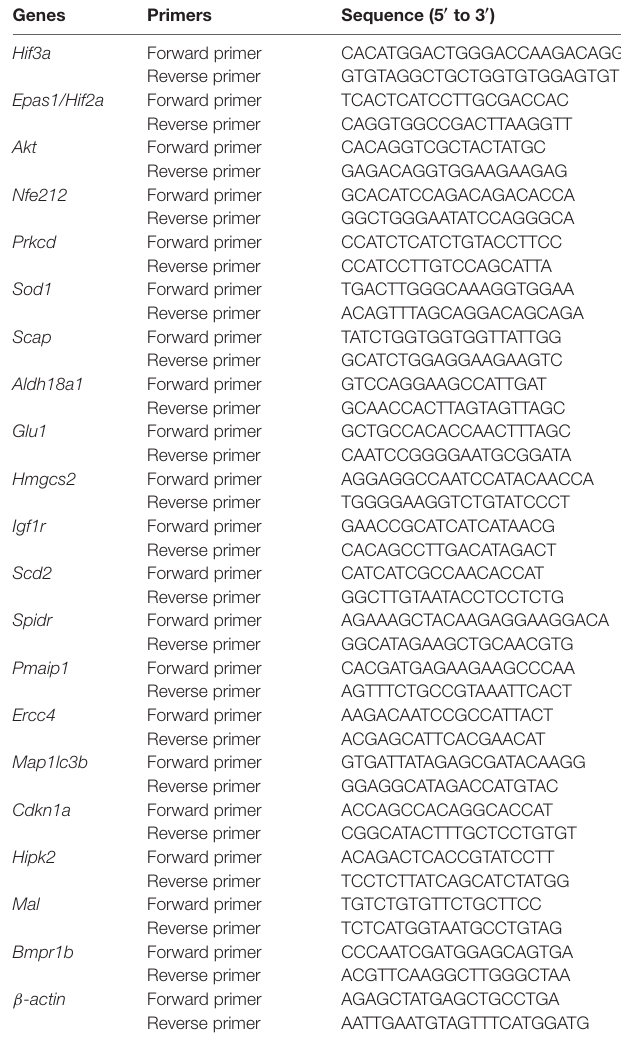
TABLE 1 | The forward and reverse primers for qPCR. Genes